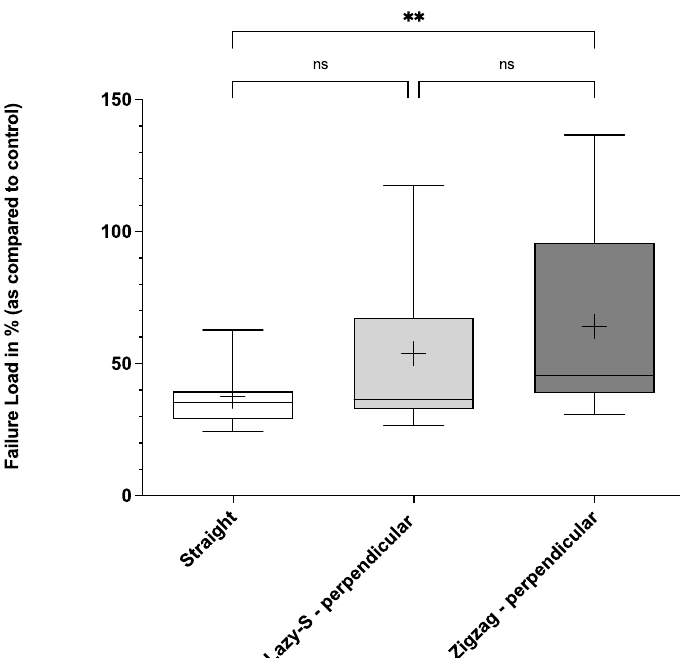
Figure 4. Second suture failure load for three main incision patterns. Conventional straight, Lazy-S and Zigzag incisions (both with perpendicular (90°) placement of sutures) were tested for their biomechanical stability. The mean is indicated by a cross. The bottom and top of the box are the 25th and 75th percentile. Error bars (whiskers) indicate the 10th and 90th percentile. ** p < 0.01; ns , not significant. For each group 17 incision-patterns were tested.